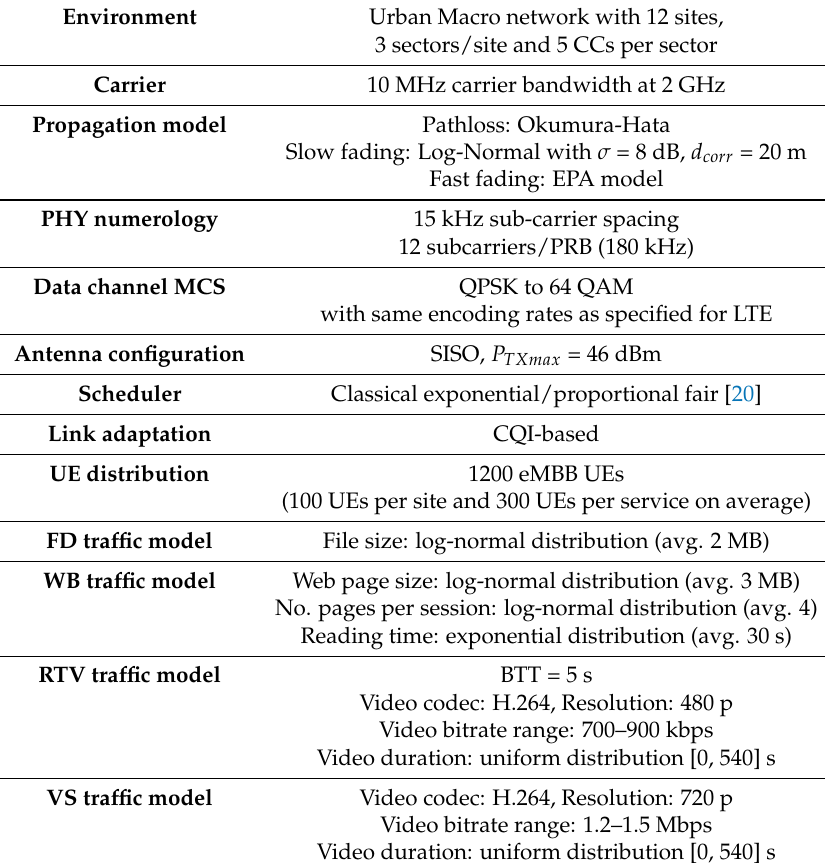
Table 1. Simulation assumptions .